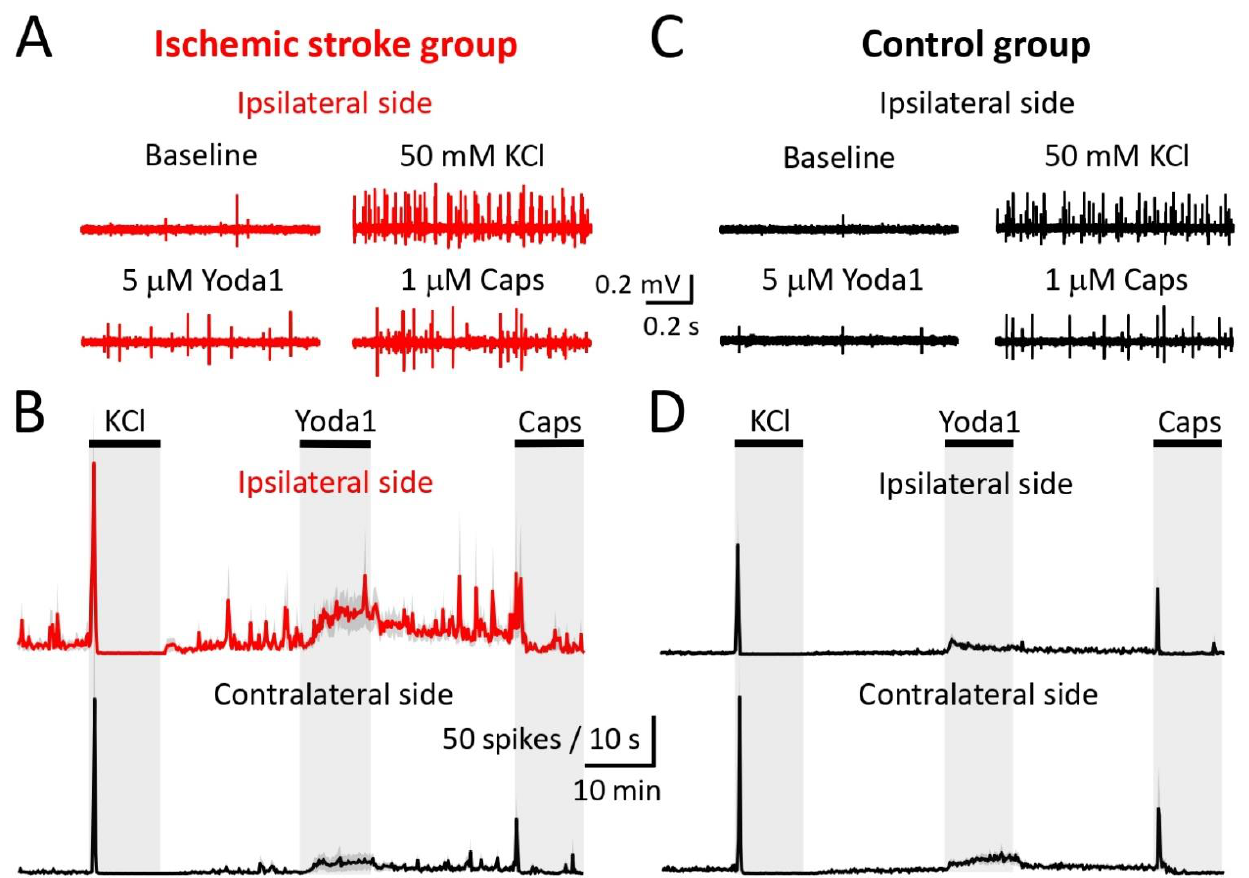
Figure 3. Examples of original electrophysiological recordings for the ipsilateral (IL) hemi-skull of the ischemic stroke group at baseline and during 50mM KCl, 5 µ M Yoda1, and 1 µ M capsaicin applications ( A ). Time course of spike frequency (10 s bin size) induced by application of 50mM KCl, 5 µ M Yoda1, and 1 µ M capsaicin, presented for both IL and contralateral (CL) hemi-skulls of the ischemic stroke group ( B ). Examples of original electrophysiological recordings for the IL hemi-skull of the control group at baseline and during 50mM KCl, 5 µ M Yoda1, and 1 µ M capsaicin applications ( C ). Time course of spike frequency (10 s bin size) induced by application of 50 mM KCl, 5 µ M Yoda1, and 1 µ M capsaicin, presented for both IL and Cl hemi-skulls of the control group. Of note, high-frequency fluctuations occur in the IL hemi-skulls of the ischemic stroke group throughout the recording period ( D ). Data are mean ±